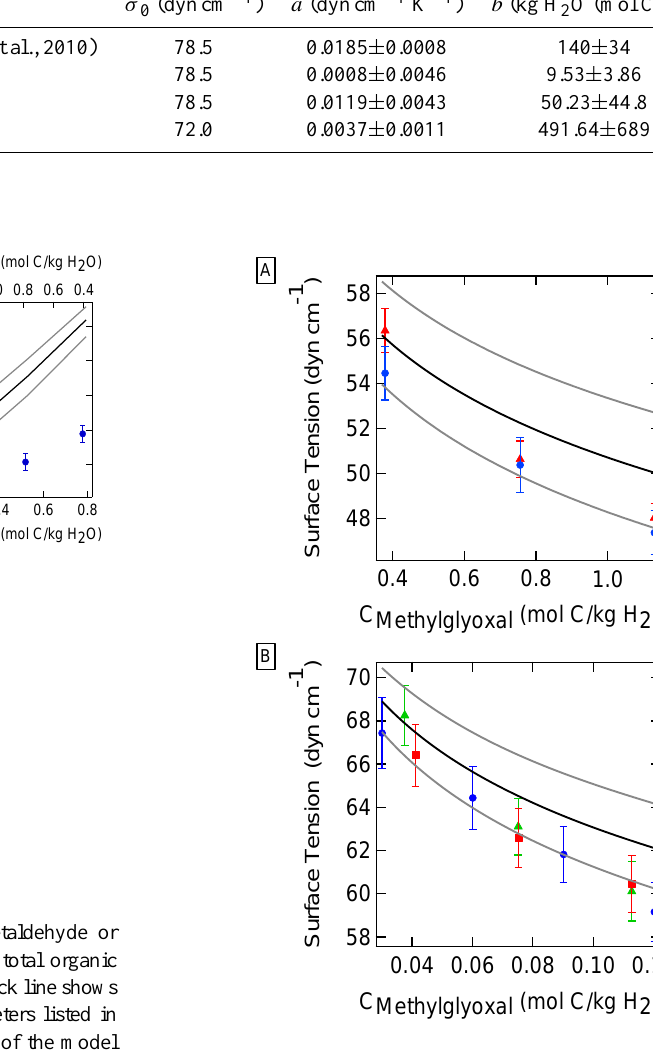
Table 1. Szyszkowski-Langmuir Fit Parameters according to Eq. (2). Mixture